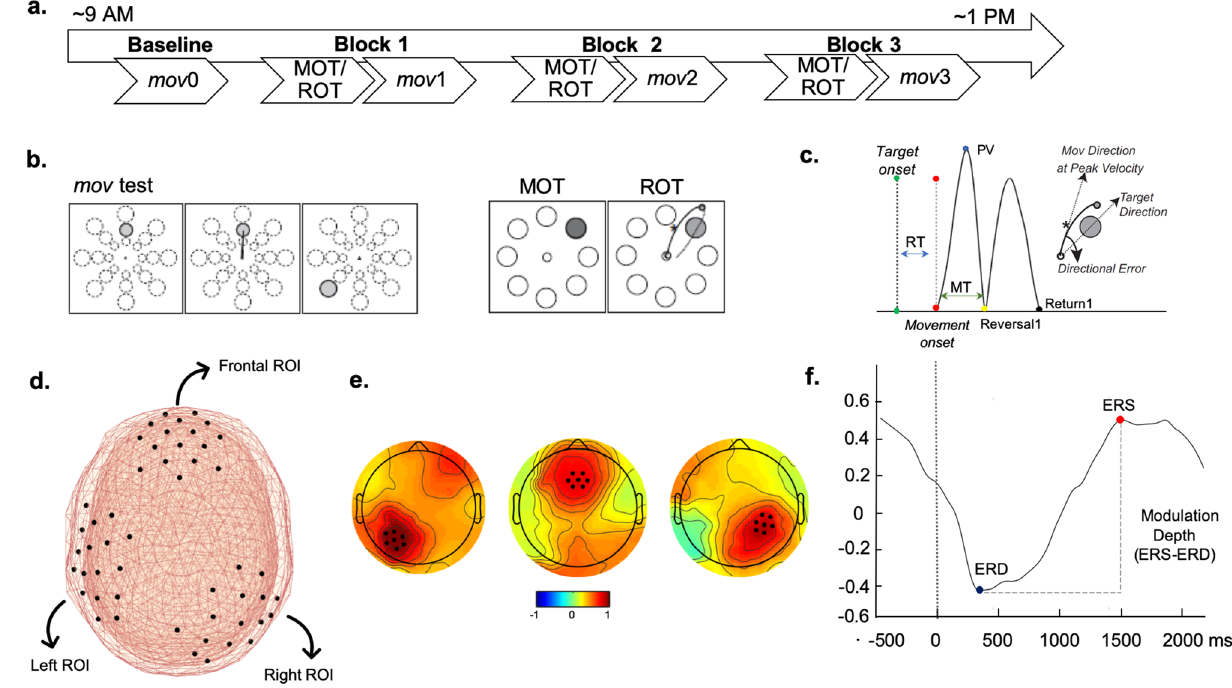
Figure 1. ( a ) Experimental design. Four blocks of a simple reaching test ( mov ) were interspaced by three 45-min blocks of practice of either ROT, an implicit visuo-motor learning task, or MOT, a motor reaching task with the same kinematic characteristics of ROT but without adaptation learning. ( b ) mov test: one of 24 targets (three distances, eight directions) appeared in unpredictable order every 3 s, ROT and MOT tasks: a circular array of 8 targets (4 cm distance) was presented on the display and one target blackened every 1.5 s in a random, unpredictable order. For both mov and ROT/MOT task, participants were instructed to reach the target as soon as possible, without correcting the movement and avoiding anticipation. In ROT the direction of the cursor was rotated relative to the trajectory of the movement in steps of 10°, 20° or 30°, either clockwise or counterclockwise. ( c ). Temporal profile of velocity showing the kinematic features considered for this study: RT, Reaction Time is the time difference between target appearance and movement onset; MT, Movement Time is the time difference between movement onset and return; PV, Peak Velocity is the first relative velocity maximum from onset to reversal; Directional error is the angular difference between the direction linking the center, the PV point and the target direction. ( d , e ) Methodology for computing beta modulation depth. ( d ) For each subject, beta ERD and ERS peak amplitude and timing were first computed on mov 0 ROT/MOT1 over three broad regions corresponding to electrodes located on the frontal, left, and right scalp regions ( e ) The peak electrode and the six neighbor ones for both Left, Frontal and Right scalp regions defined the personalized ROIs. ( f ) Beta modulation depth is defined by the amplitude difference between the peak ERS and peak ERD in the